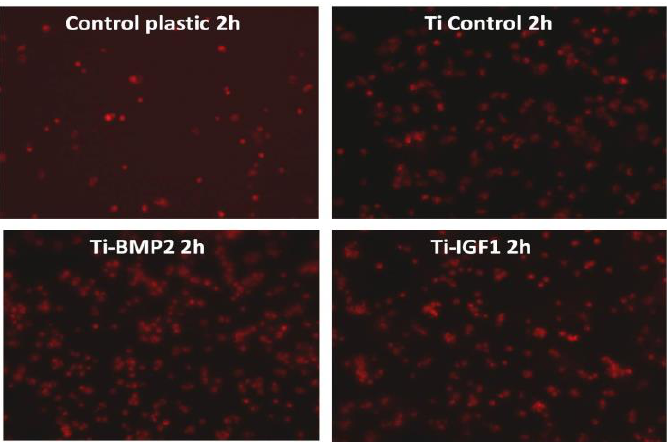
Figure 9. Cells with red fluorescence at the surface of the plastic wells and of the titanium discs